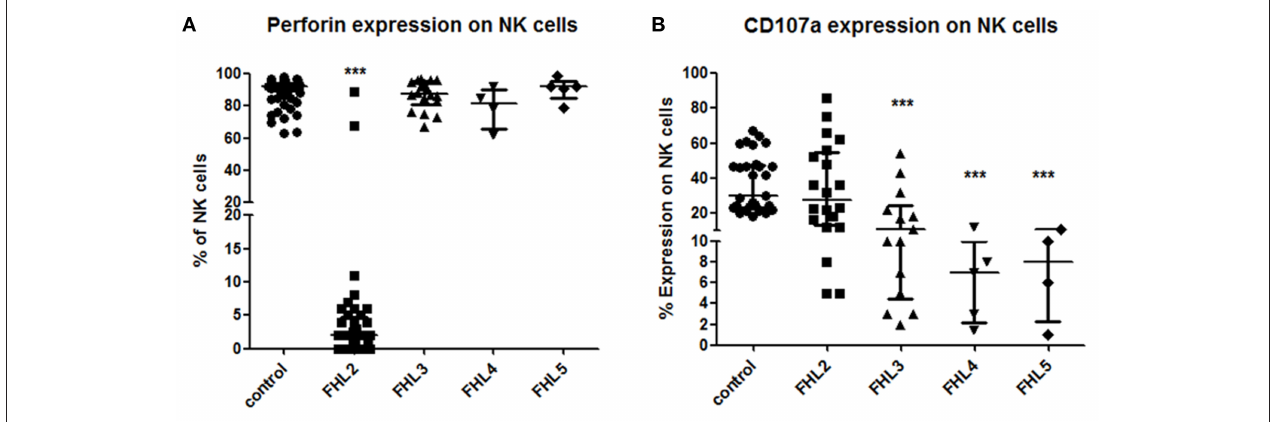
FIGURE 1 | Comparison of Perforin expression and CD107a expression on stimulated NK cells in different groups of FHL patients (A) Perforin expression (B) CD107a expression. One way ANOVA test was used to evaluate differences between activation markers in different groups. *** P <